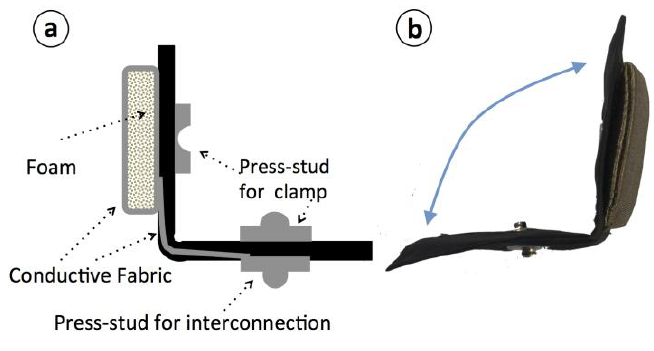
Figure 9. ( a ) Schematic of the repositionable textrode. Notice that when folded the electrode is clamped using its male and female press-studs, thus creating an electrical and mechanical connection. ( b ) Confectioned repositionable